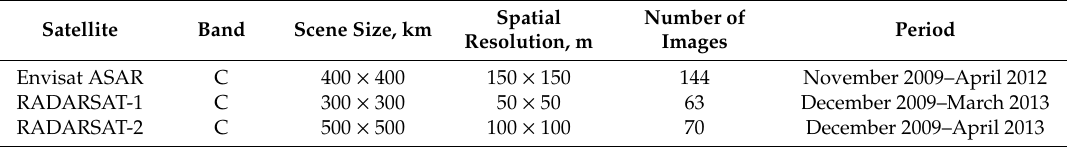
Table 1. Main characteristics of spaceborne SAR images used in the